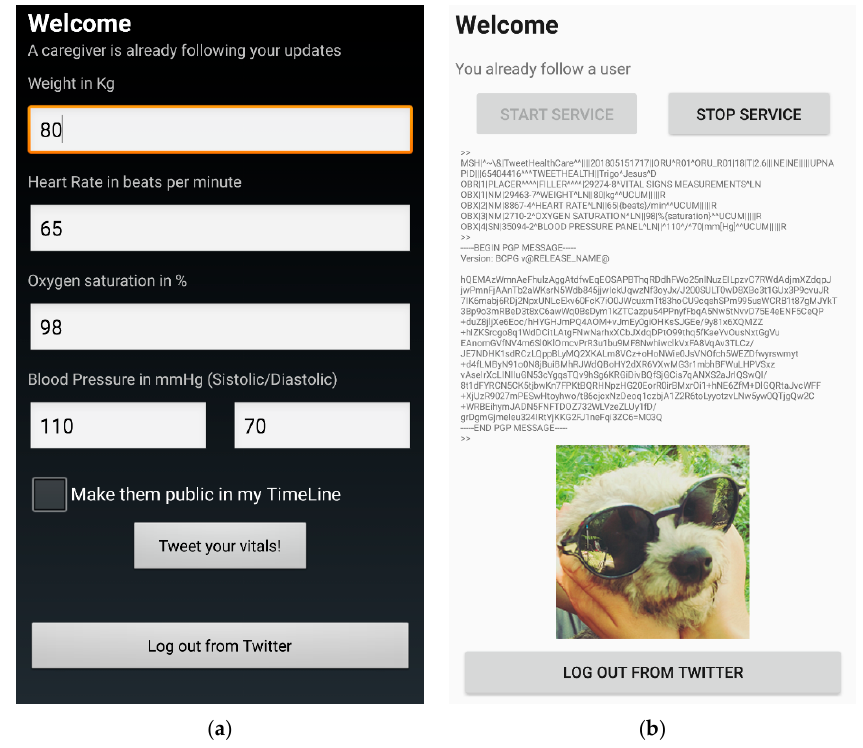
Figure 4. Android applications: ( a ) for users or patients (at this point, the user is already logged in and a caregiver is already following the updates); ( b ) for caregivers (the user is already logged in, the caregiver is following someone’s updates, an image with biomedical data has already arrived, and such data have been de-embedded and decrypted). The first rows have data embedded.